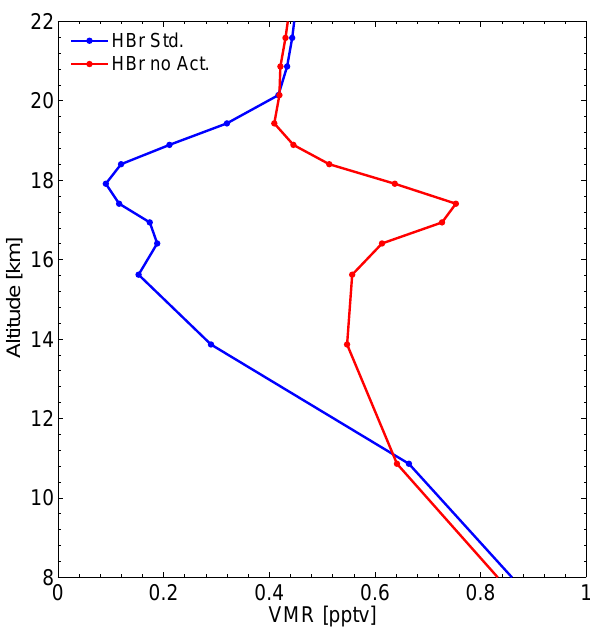
Fig. 7. Tropical profiles of HBr from the standard full chemistry run (blue) and the sensitivity calculation without heterogeneous ac- tivation (red) for